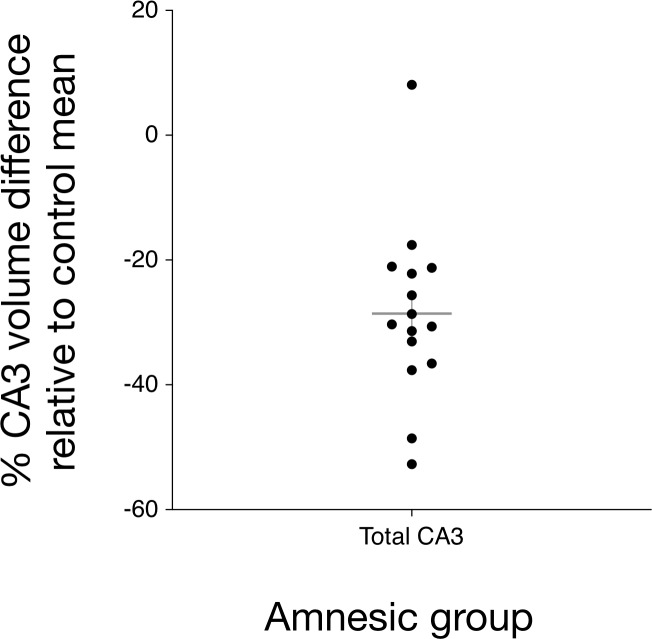
Bilateral hippocampal CA3 volume loss in the amnesic group.The graph depicts the reduction in CA3 subfield volume (CA3 subfield volume was corrected for total intracranial volume) relative to the control group mean. Error bars correspond to the s.e.m. and the horizontal line corresponds to the mean. A three-way mixed-model ANOVA, with two within-subjects factors (subfield and side) and one between-subjects factor (group), was used to test for differences in hippocampal subfield volumes between the amnesic (N = 15) and control (N = 15) groups. The assumption of sphericity was violated for subfield (χ2(9) = 52.46, p<0.0001) and for the interaction between subfield and side (χ2(9) = 63.48, p<0.0001), so degrees of freedom were corrected using Greenhouse-Geisser correction (ɛ = 0.551). Significant two-way interactions were found between group and subfield (F(5.30,61.74) = 5.30, p=0.006), and between side and subfield (F(2.02,56.55)=14.15, p<0.0001), but not between group and side (F(1,28) = 1.25, p=0.272). The three-way interaction was not significant (F(2.02,56.55) = 0.43, p=0.66). Subfield volumes were collapsed across left and right due to the absence of the significant three-way interaction. Significant bilateral CA3 volume loss was seen in the amnesic group relative to the control group (F(1,28) = 14.52, p=0.001, Cohen’s d = 1.39; mean reduction = –29%), whereas the differences in CA1, CA2, subiculum, and dentate gyrus volumes were not statistically significant at the Holm-Bonferroni alpha criterion corrected for multiple comparisons. Mean normalized total volumes for all segmented subfields are reported in Table 1 and subfield volumes for individual participants are plotted in Figure 2—figure supplement 1. 7.0-Tesla 3-D fast-spin echo scans and results from manual volumetry are a subgroup of those reported in our previous clinical study involving 18 participants at the chronic phase of the LGI1-antibody-complex LE phenotype (Miller et al., 2017).